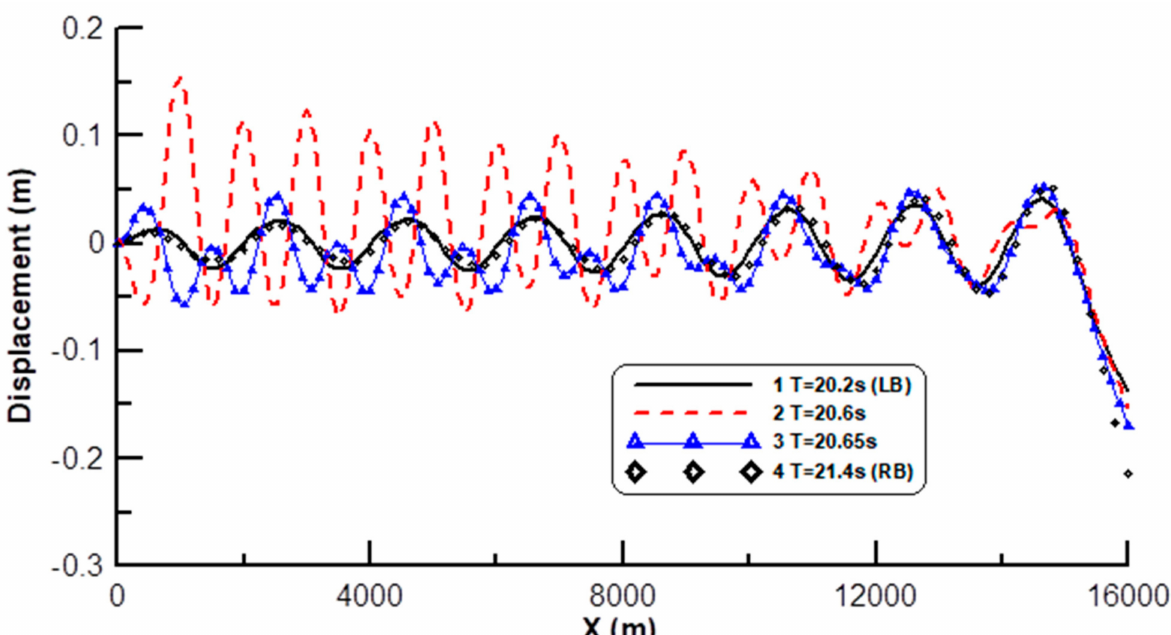
Figure 5. Ice-tongue flexures along the central line obtained at different periodicities of the forcing ( T ) beside and inside the first “band gap” (Figure 3). Curves 1 and 4 are the ice-tongue flexures beside the first “band gap”, respectively, obtained at T = 20.2 s and at T = 21.4 s. Curves 2 and 3 are the ice-tongue flexures inside the first “band gap”, respectively, obtained at T = 20.6 s and at T = 20.65 s. The crevasses’ depth is equal to 20 m. Spatial periodicity of the crevasses is equal to 1